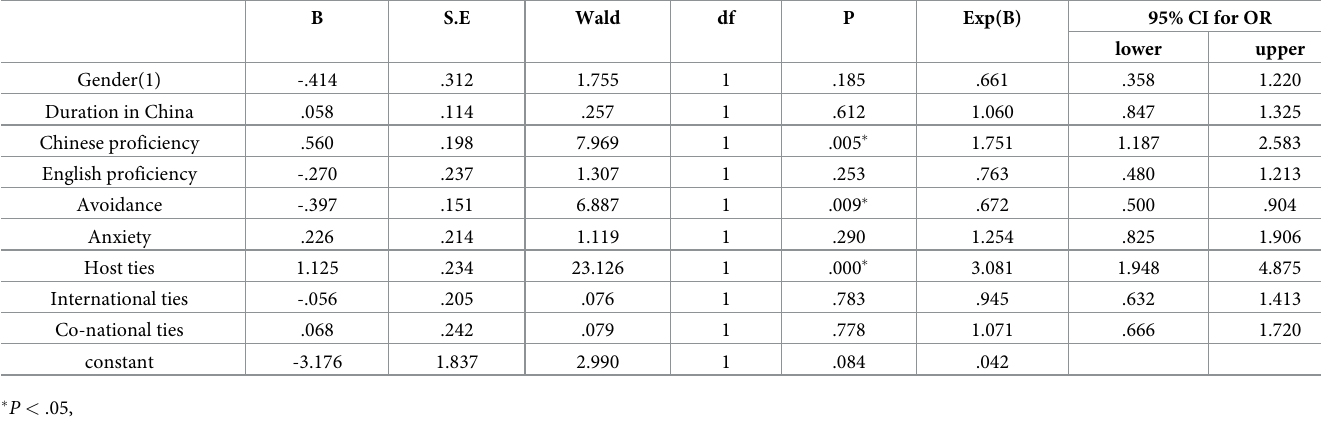
Table 5. Logistic regression predicting likelihood of adopting integration attitude.